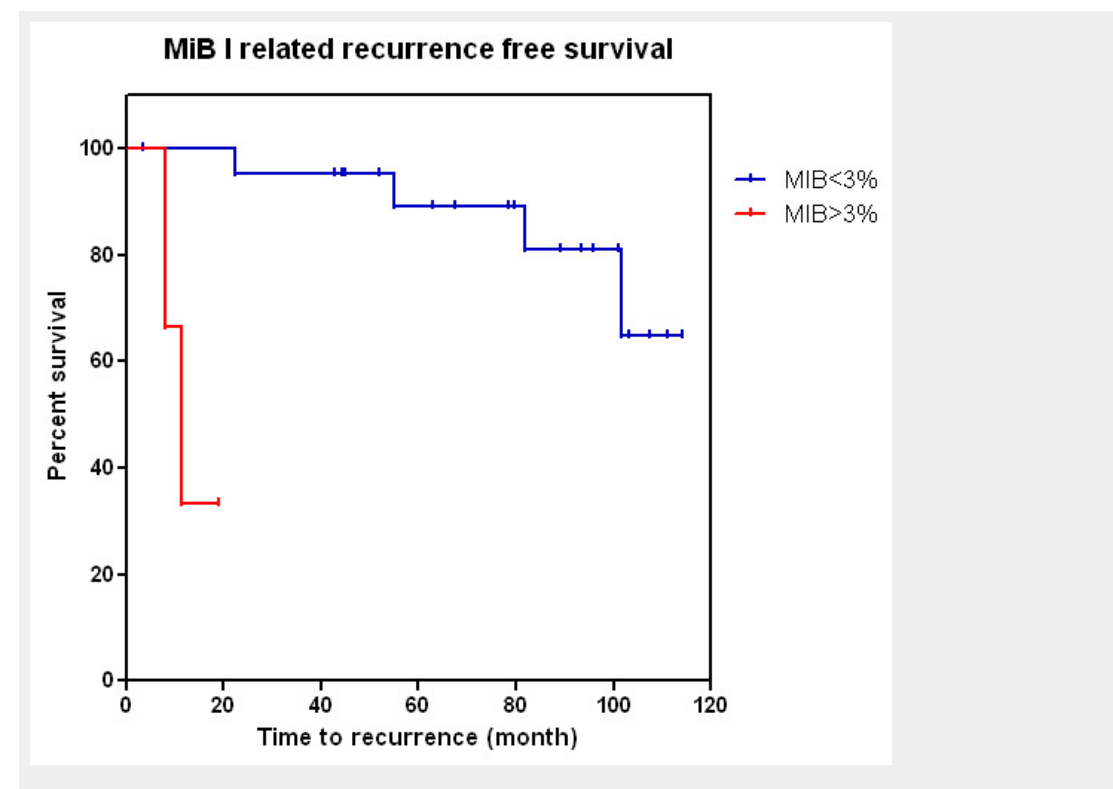
Figure 3 Kaplan-Meier curve showing MIB-1 (Ki-67) proliferation index and time to recurrence: cases with higher MIB-1 proliferation index are more likely to recur (p